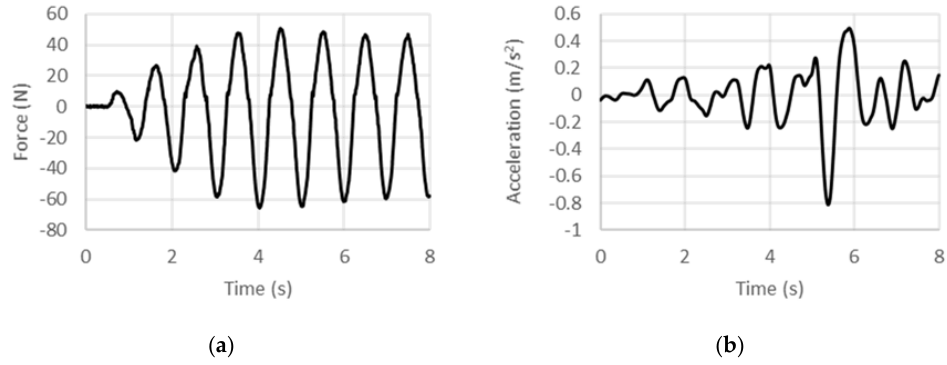
Figure 7. Experimental ( a ) force and ( b ) acceleration histories at 1 Hz under displacement